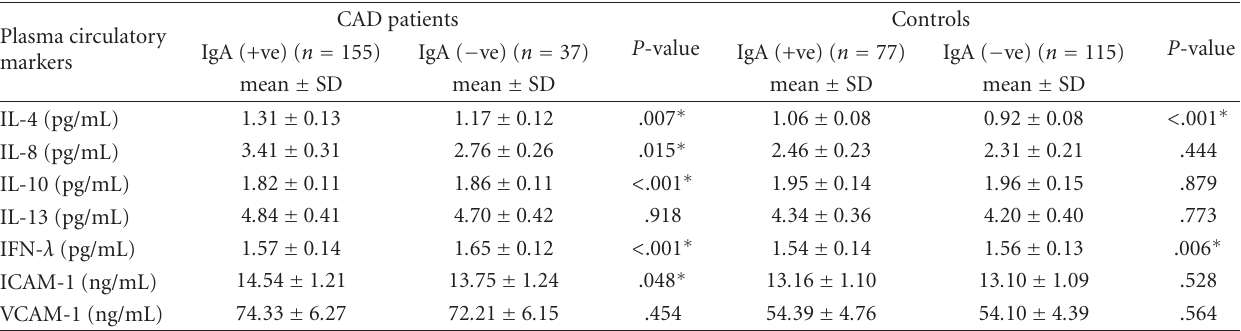
Table 3: Evaluation of plasma circulatory markers in Chlamydia pneumoniae IgA positive coronary artery disease patients and controls. Plasma circulatory markers